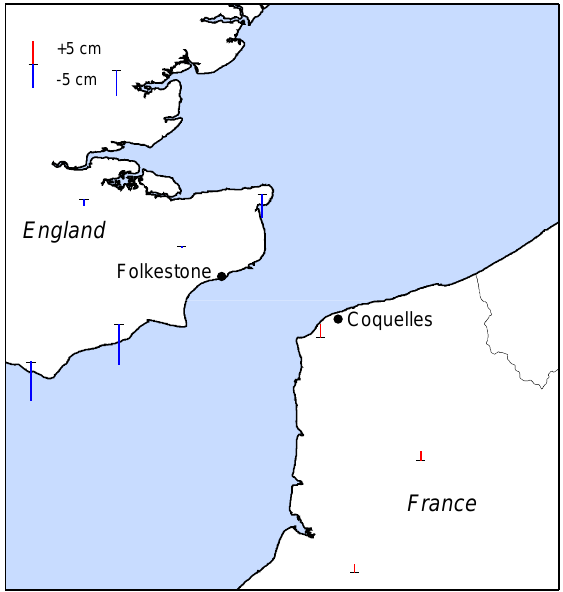
Figure 7. Residuals of observed height anomalies at European GNSS/leveling points vs. plane model computed with the GF approach in the Channel region. The filter-combined GOCO03S+EGG2008 model has been used as the grav- ity field